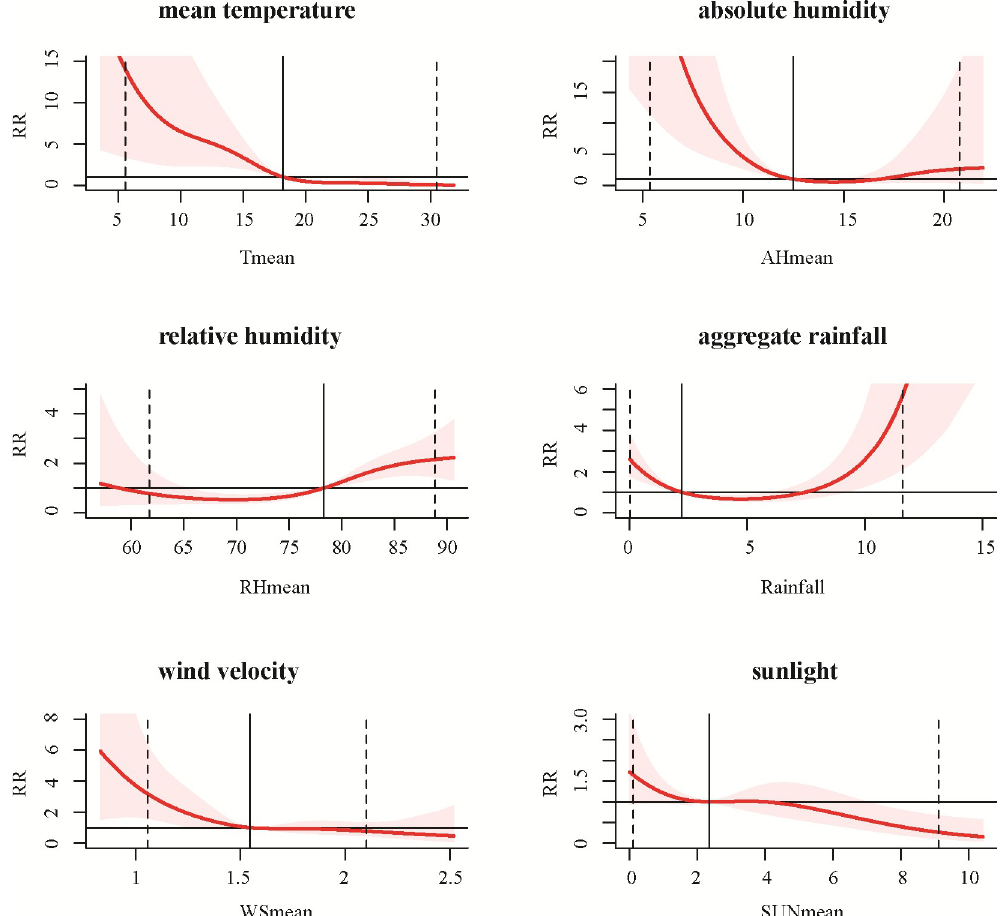
Fig 3. The estimated overall effects of mean temperature, absolute humidity, relative humidity, aggregate rainfall, wind speed, and sunshine along corresponding lag days. In each panel, the y-axis represents the value of relative risk, and the x- axis represents the values of the corresponding relevant variable. The red line and grey region represent the relative risk and its 95% confidence interval, respectively. The black vertical line represents the median of the corresponding meteorological factor, and the two dashed lines represent the 2.5 percentile and the 97.5 percentile for the corresponding meteorological factor, respectively.